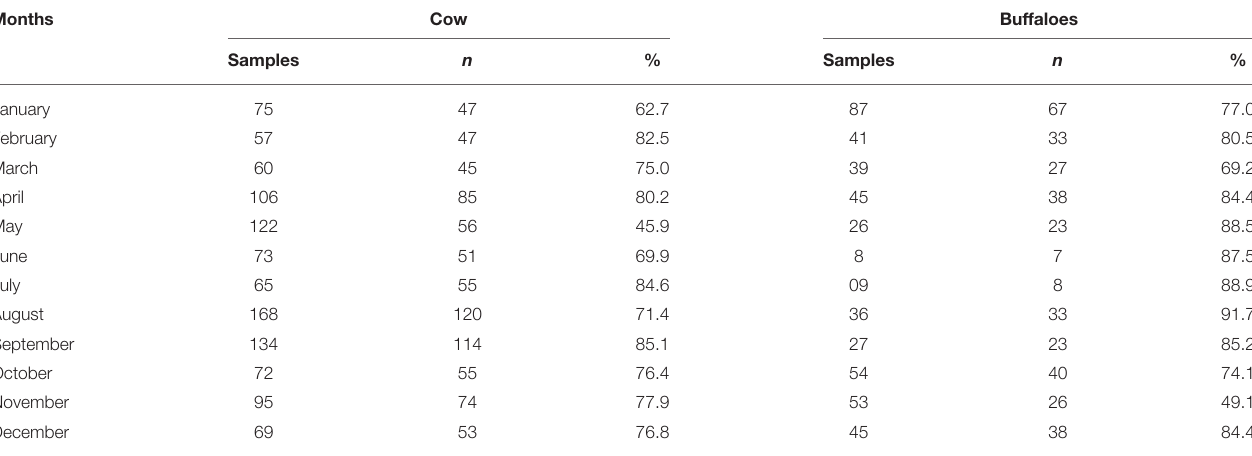
TABLE 3 | Month-wise prevalence of bovine mastitis in cattle and buffaloes. Months Cow Buffaloes